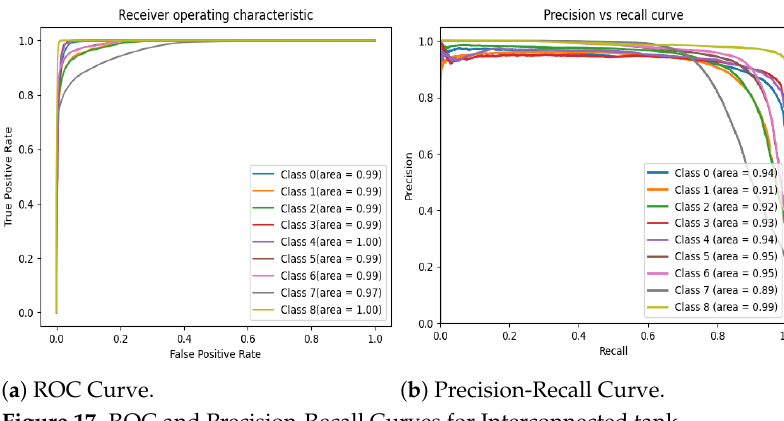
Figure 17. ROC and Precision-Recall Curves for Interconnected tank. Table 7. Summary of